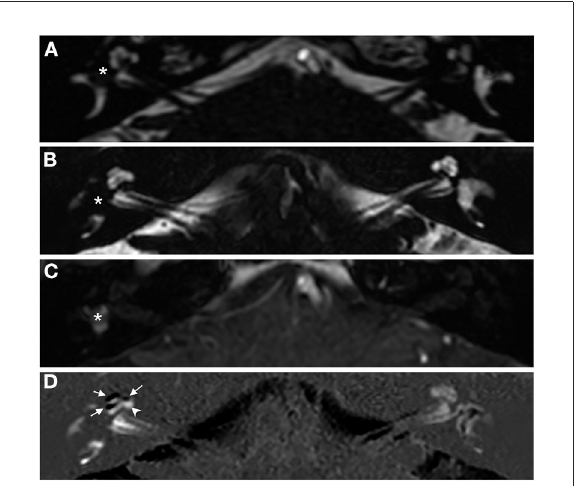
FIGURE2 Axial magnetic resonance (MR) images obtained from a patient with concurrent right intravestibular schwannoma and endolymphatic hydrops in the right cochlea. (A) MR cisternography images obtained 4 years after the patient’s initial visit to our department. (B–D) MR images obtained 12 years after the patient’s initial visit to our department. (A,B) MR cisternography revealed a filling defect in the right vestibule (asterisks). (C) Gadolinium-enhanced T1-weighted imaging showed an enhanced region in the right vestibule indicating the presence of a hypervascular mass (asterisk). (D) Delayed 3D-FLAIR image, subtraction of the positive endolymphatic image from the positive perilymphatic image revealed black areas (arrowheads) representing the right cochlear hydrops and diffuse perilymphatic hyperintense area (arrowhead) indicative of blood–labyrinth barrier